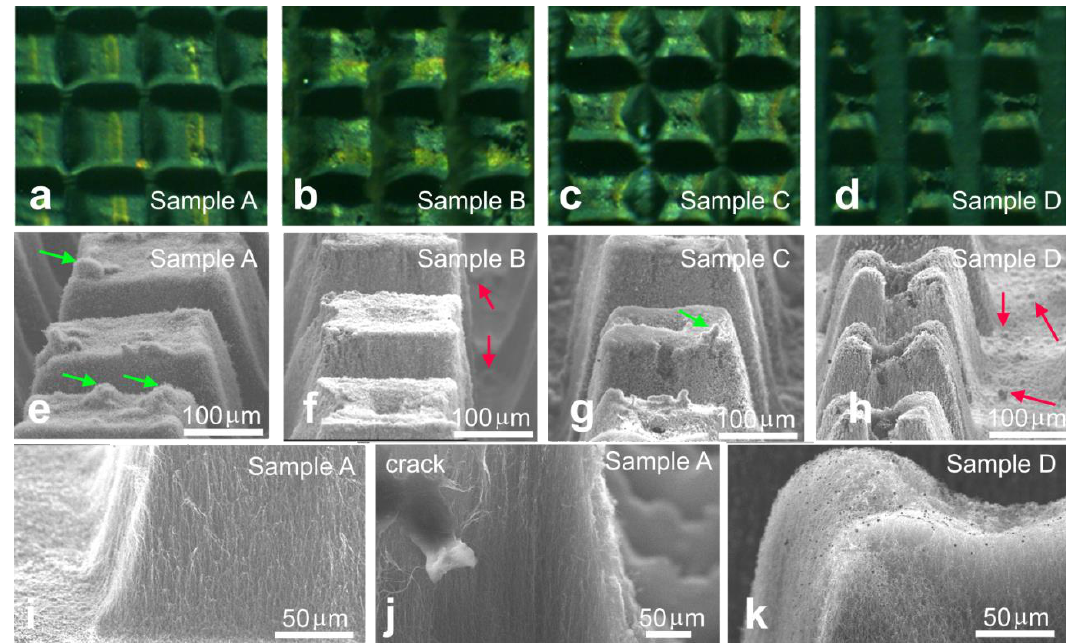
Figure 1. Optical and SEM images of Sample A ( a and e , i , j ), Sample B ( b and f ), Sample C ( c and g ), and Sample D ( d and h , k ).